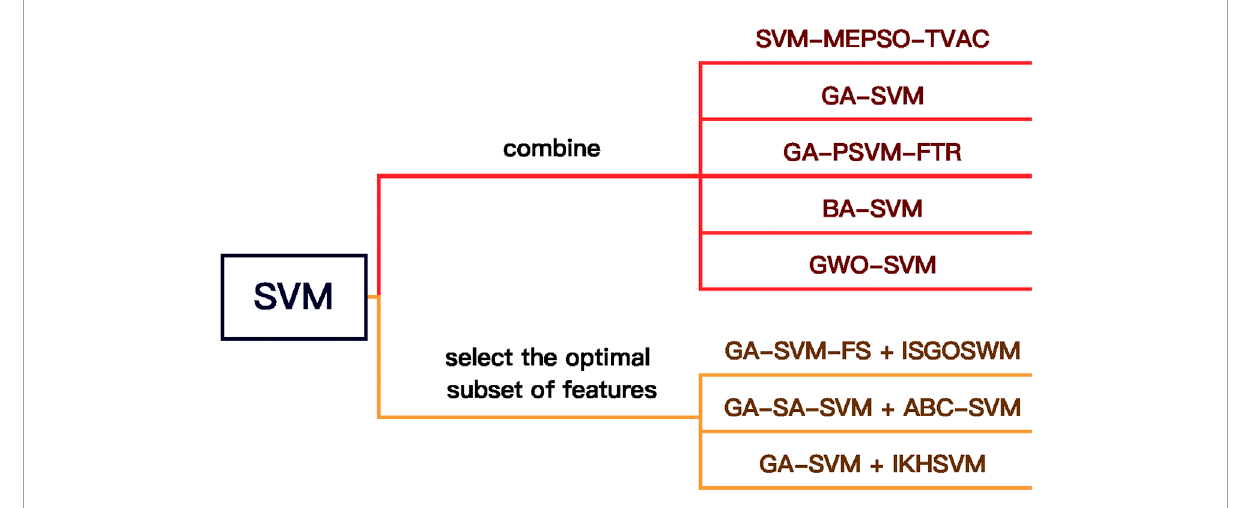
FIGURE 4 Improved SVM-based methods for fault